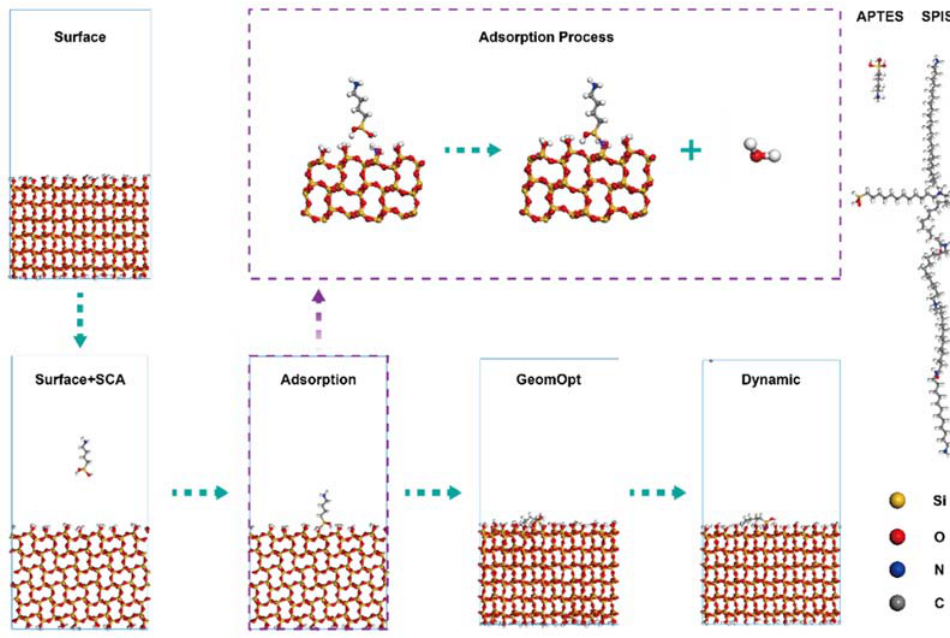
Figure 3. MD simulation process of the SCAs.